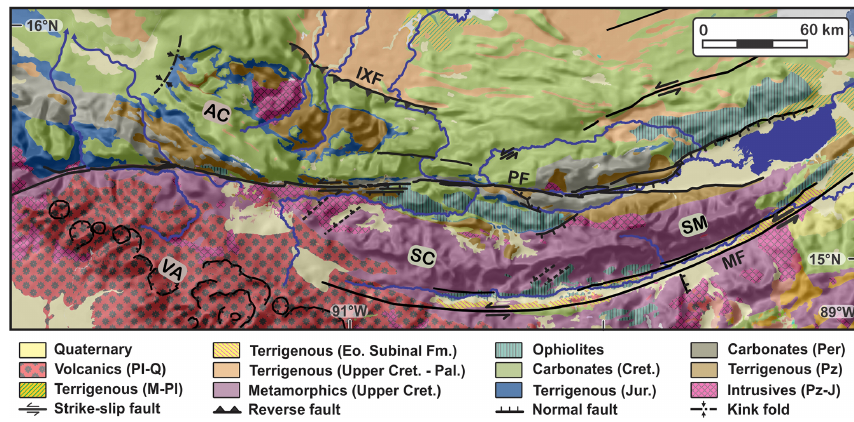
Figure 5. Geology and structure of central Guatemala (Instituto Geográfico Nacional de Guatemala; Instituto Hondureño de Geología y Minas; Instituto Nacional de estadística y geografía de México), draped over the GTOPO 30 DEM. AC stands for Altos de Cuchumatanes, IXF stands for Ixcán fault, MF stands for Motagua fault, PF stands for Polochic fault, SC stands for Sierra de Chuacús, SM stands for Sierra de las Minas, and VA stands for volcanic arc.